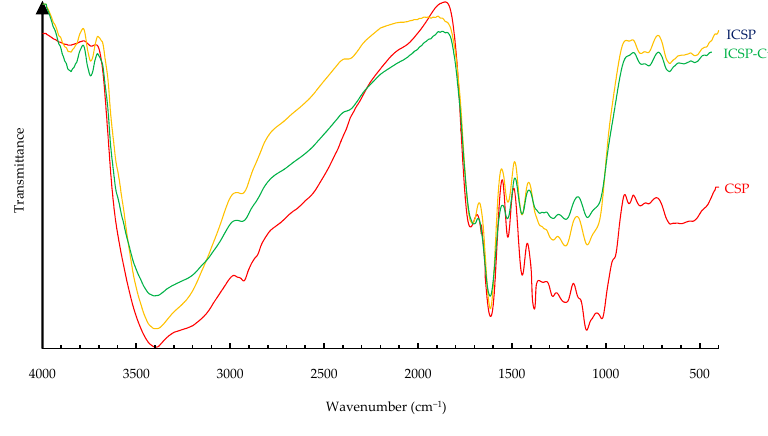
Figure 4. FT–IR spectra of CSP, ICSP and copper loaded ICSP.